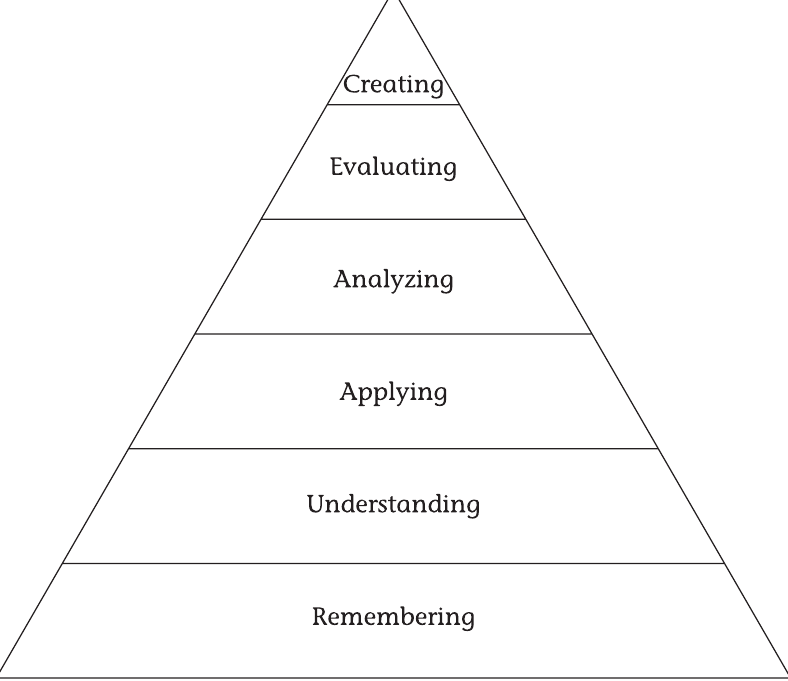
Figure 4: Krathwohl’s revised Bloom’s